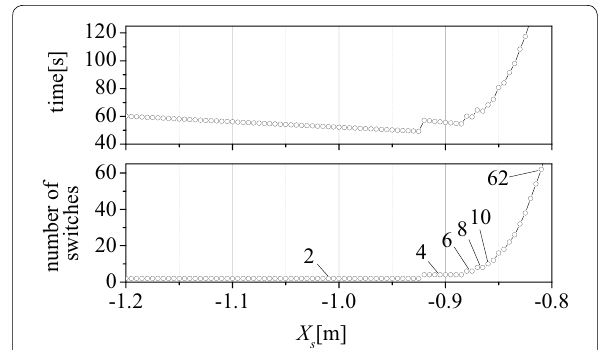
Fig. 14 Number of times of switching and time taken for the con- vergence conditions to be satisfied when X s is changed in numerical